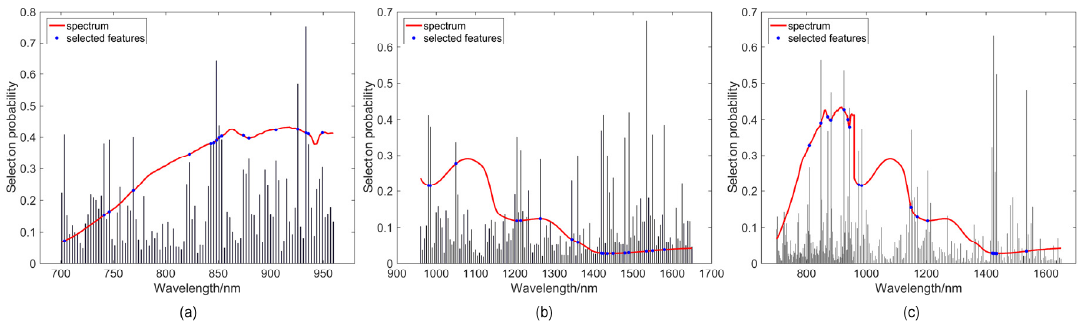
Figure 7. Distribution of features selected by the random frog algorithm from the ( a ) push broom based and ( b ) LCTF based hyperspectral data, and ( c ) their fused data.